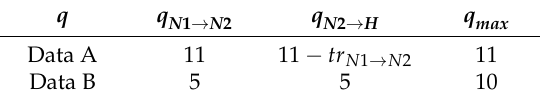
Table 2. Maximum number of